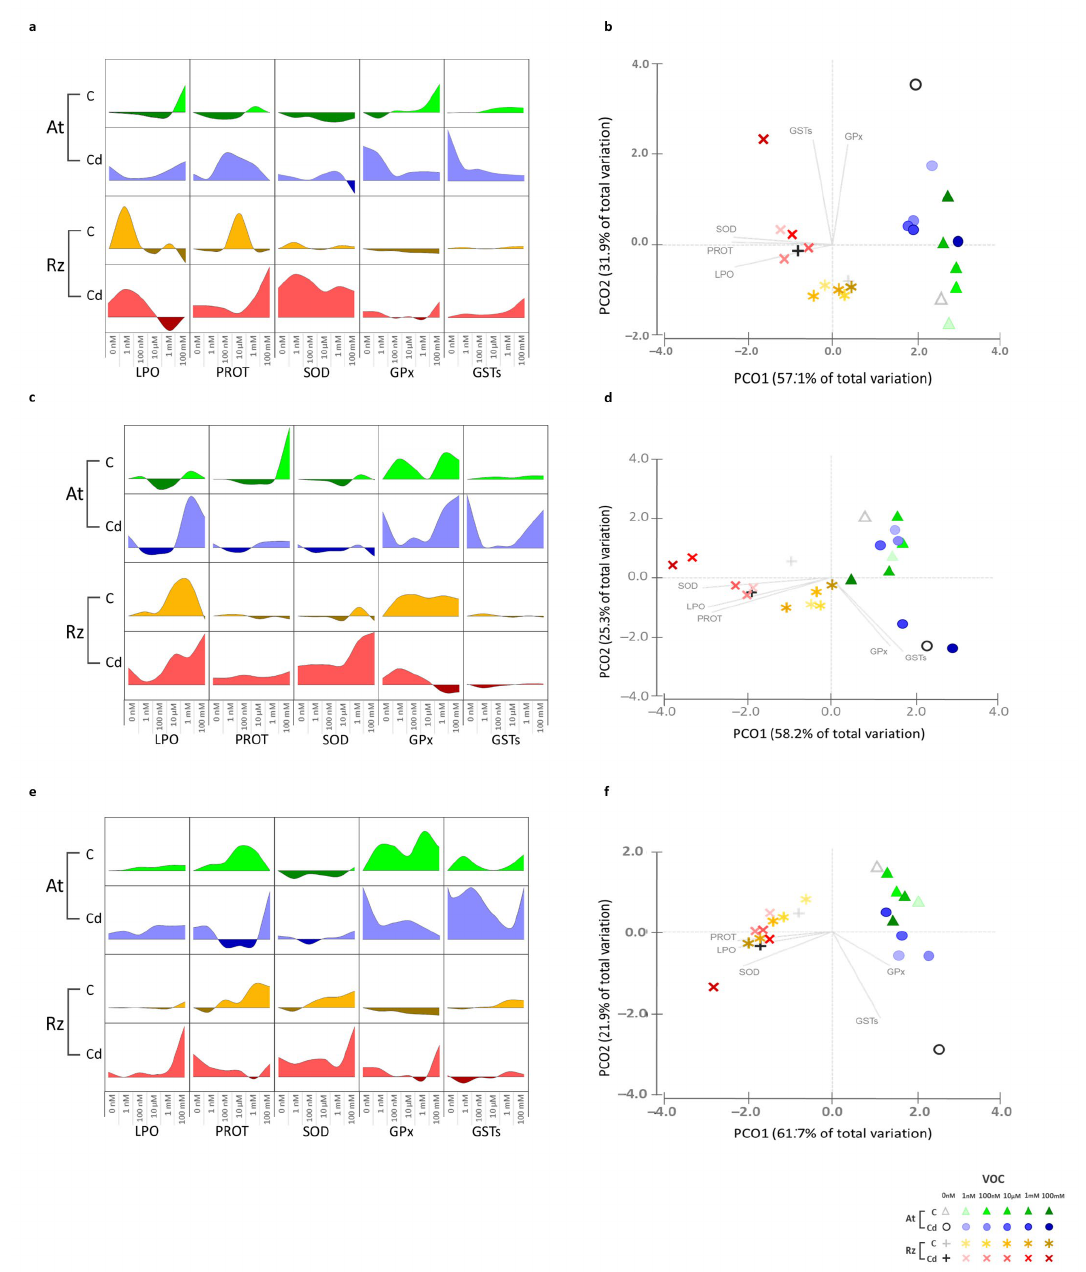
Figure 3. Antioxidant and biotransformation activity and damage (no Cd and no VOC). A. thaliana and Rhizobium were simultaneously exposed to 2 Cd conditions (0 and 100 µ M) and 6 concentrations (0 nM, 1 nM, 100 nM, 10 µ M, 1 mM, and 100 mM) of 2,3-butanediol ( a , b ); 3-methyl-1-butanol ( c , d ); 2-butanedione ( e , f ) conditions. VOC on one side of l-plates and plants/bacteria on the other. Variation relatively to control ( a , c , e ) of lipid peroxidation (LPO), protein (PROT), superoxide dismutase activity (SOD), glutathione peroxidase (GPx), and glutathione S-transferases (GSTs). A. thaliana at 0 µ M Cd (light green for positive, dark green for negative variation), A. thaliana at 100 µ m Cd (light blue for positive, dark blue for negative variation), Rhizobium at 0 µ M Cd (yellow for positive, ocher for negative variation), and Rhizobium at 100 µ m Cd (pink for positive, red for negative variation). Data range of the same parameter is set to the same scale. Values are means of 4 replicates. For statistical significance, see Supplementary Table S2. Principal coordinates with centroids ordination (PCO) of the biochemical determinants for each condition ( b , d , f ); detailed color scheme in the figure. Pearson correlation vectors (LPO, PROT, SOD, GPx, and GSTs) (r ≥